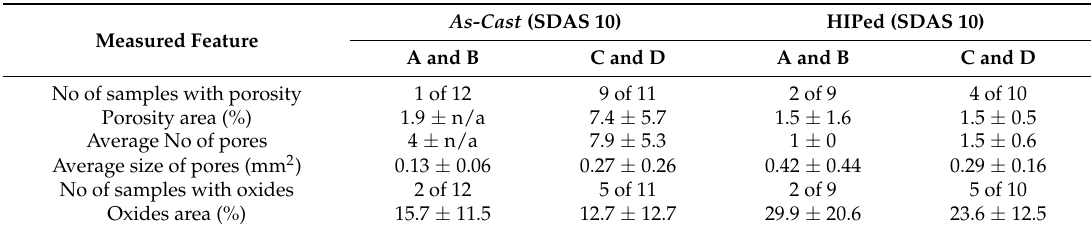
Table 3. Results of measurements ± standard deviation, made at the fracture surface of images taken with a stereo